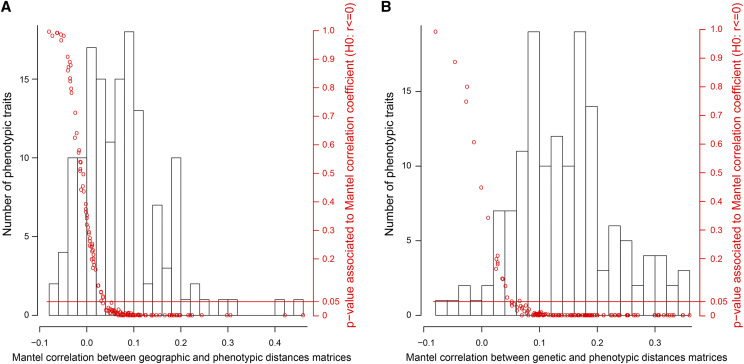
Histograms for all available traits of the Mantel correlation values between phenotypic and geographic Euclidian distances and between phenotypic and genetic Euclidian distances. Genetic Euclidian distances were computed using the allele frequencies of all available SNP markers. The red dots give the one-tailed p-value associated to each Mantel correlation value. The red horizontal line indicates the 5% p-value threshold below which the traits represented by the dots are considered to have phenotypic pairwise distances significantly correlated to geographic or genetic pairwise distances.